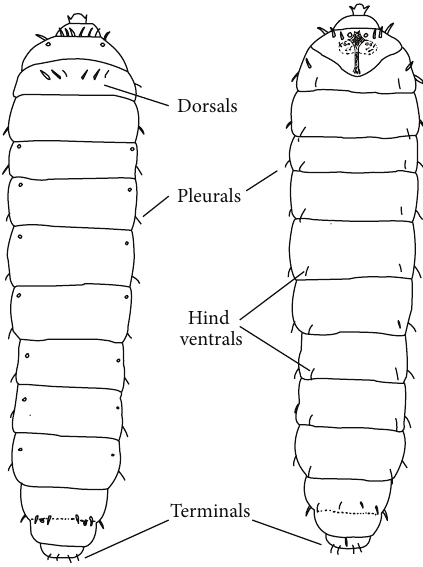
Figure 13: Diagrammatic position of setiform papillae on the third instar, dorsal on left, ventral on